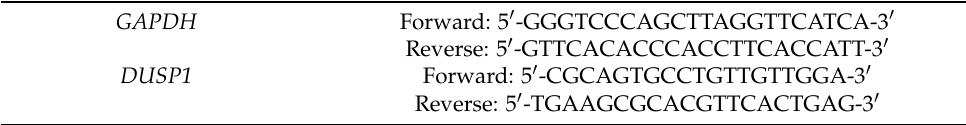
Table 1. The primer sequence of each gene measured in the present study. GAPDH Forward: 5 (cid:48) -GGGTCCCAGCTTAGGTTCATCA-3